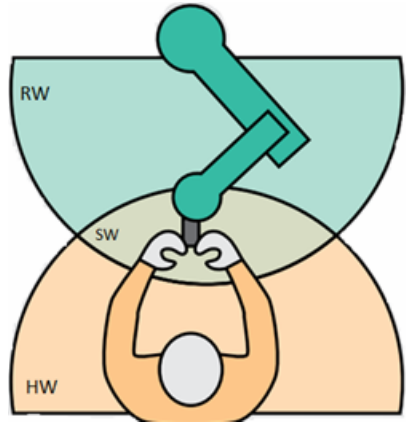
Figure 1. HRC workspace sharing: RW, HW and SW are respectively robot, human and shared